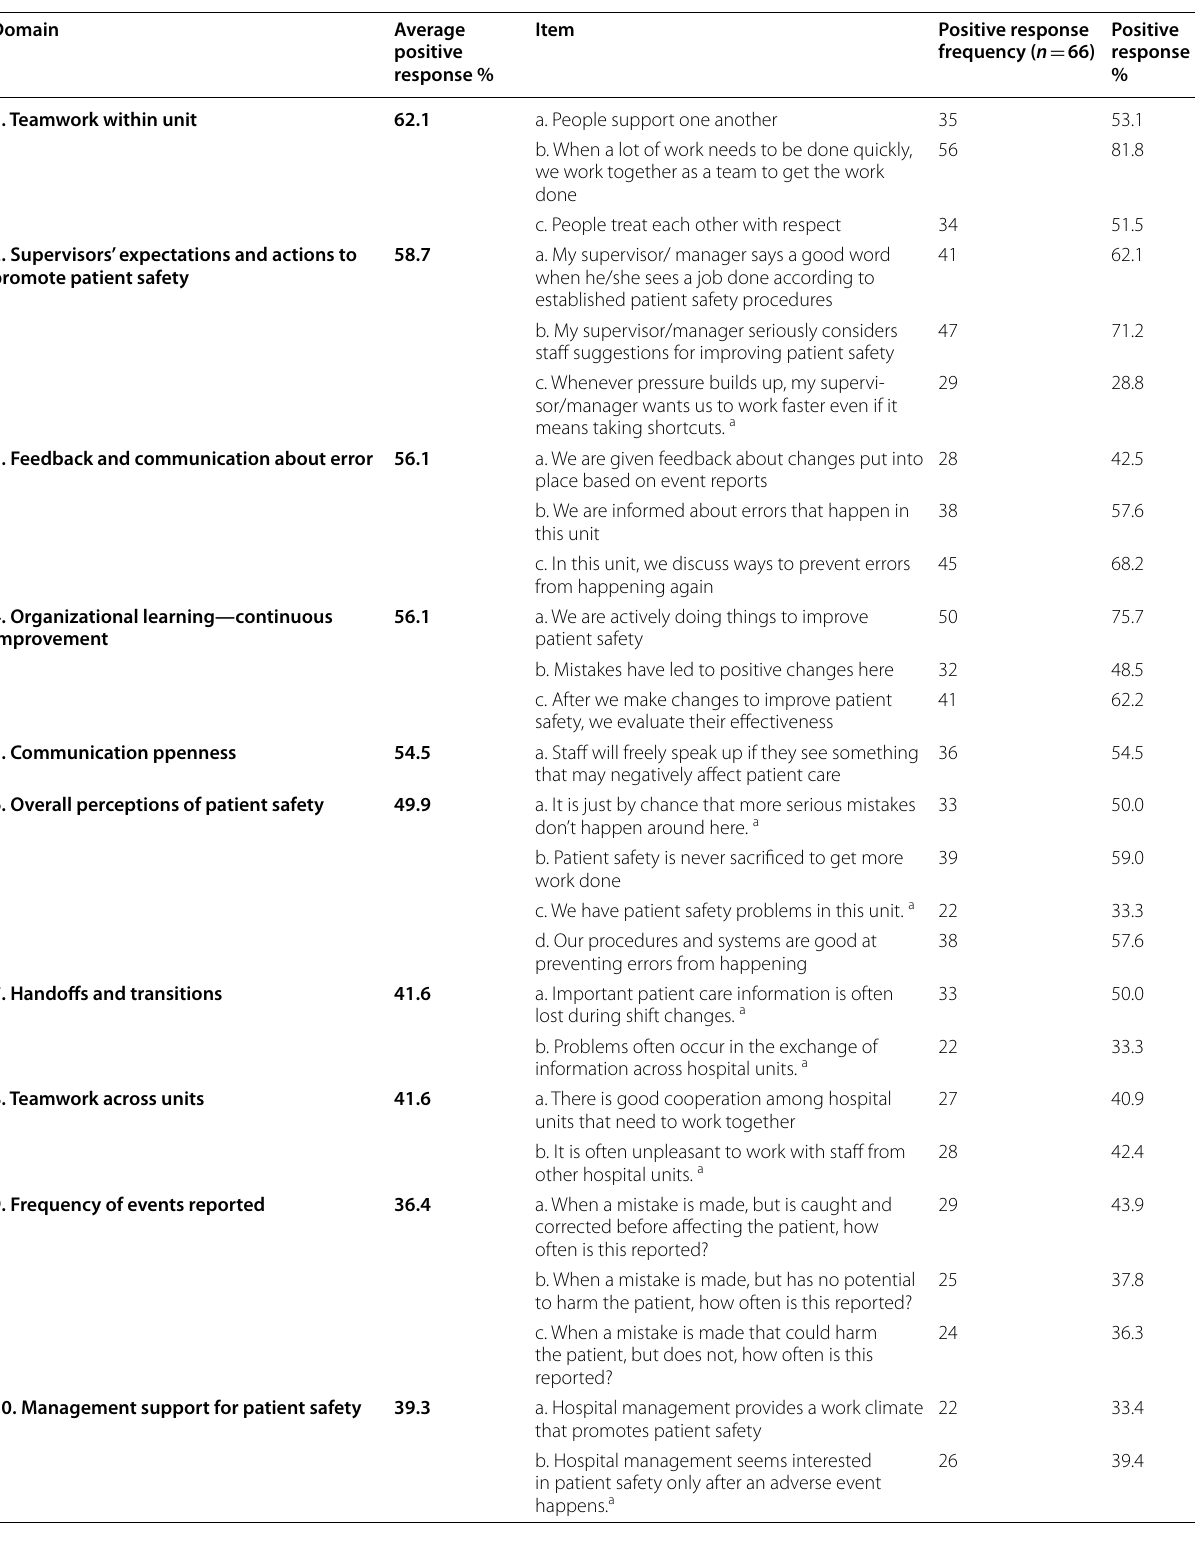
66) of El‑Shatby University Hospital for Gynecology and obstetrics during the study =